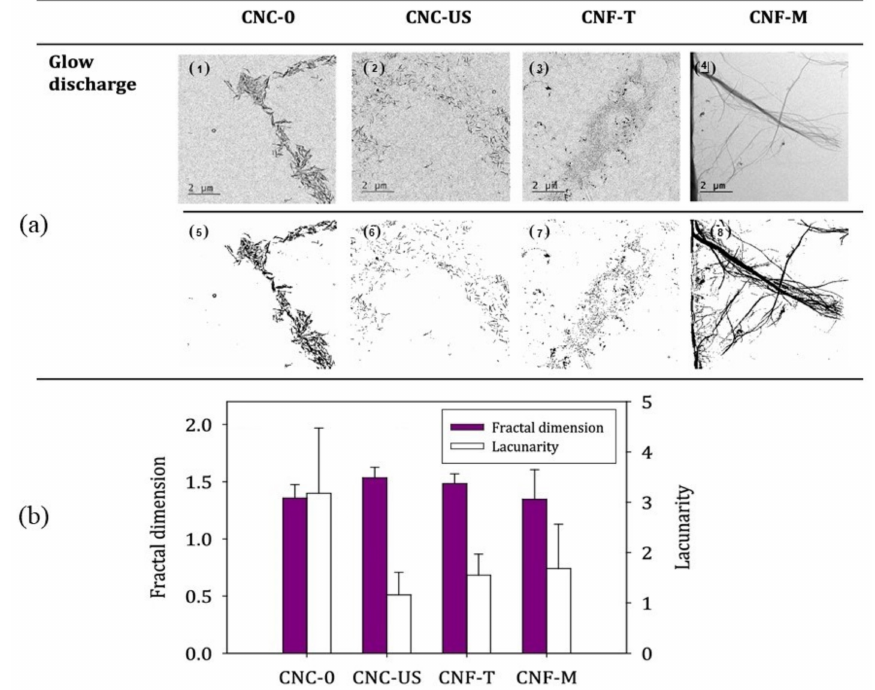
Figure 9. TEM images ( a ) (pretreated through glow discharge (subfigures 1 – 4 ) and processed images (subfigures 5 – 8 )) and fractal dimension ( b ) of CNCs and CNFs